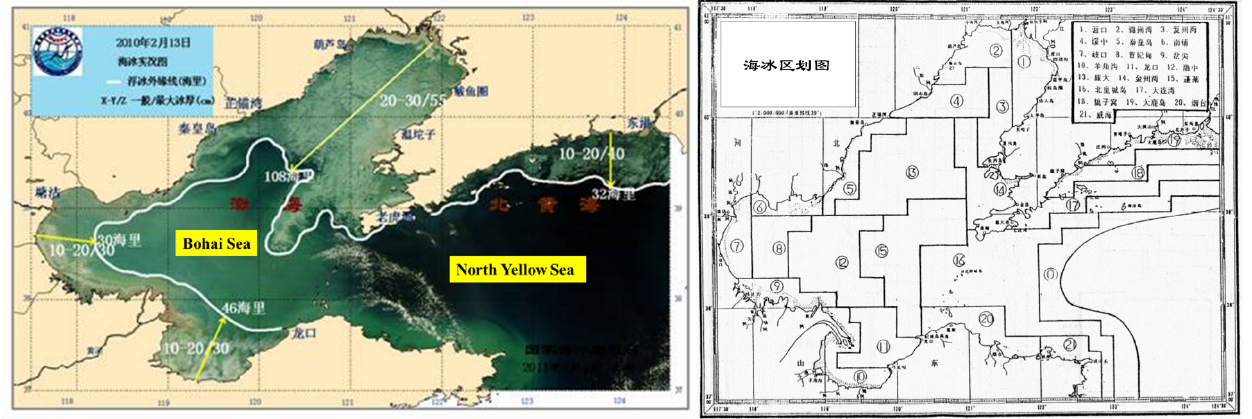
Figure 1. Location map of Bohai Sea and northern Yellow Sea (State Oceanic Administration, 2010; China National Offshore Oil Corpora- tion,